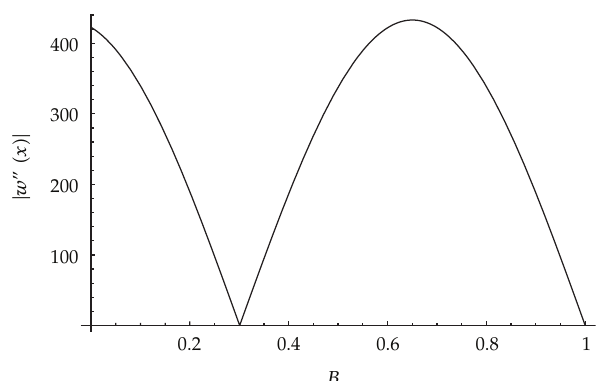
Figure 10: Graph of the magnitude of the curvature for B (cid:5) 4 .